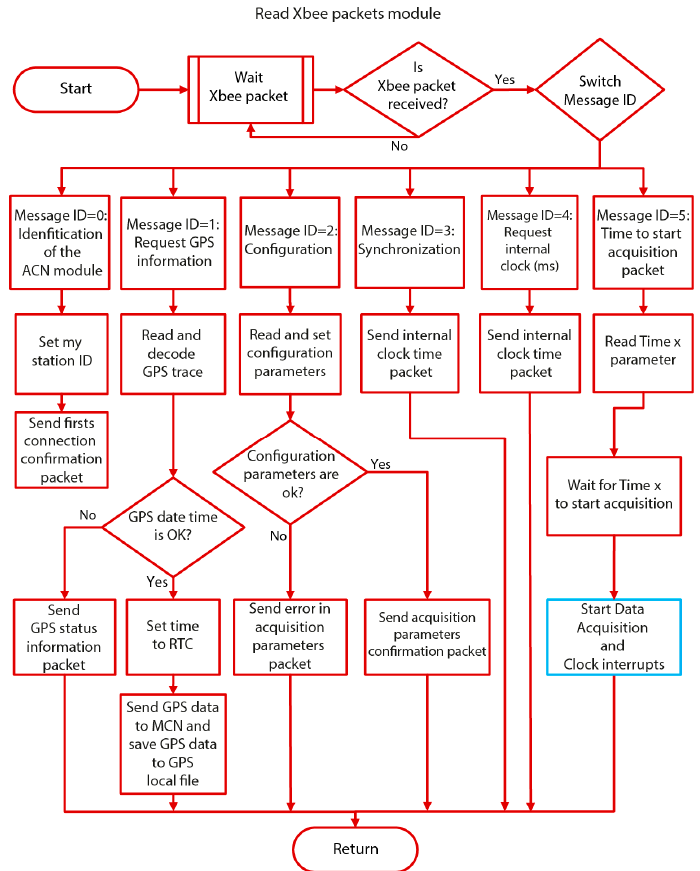
Figure 9. General flowchart of the ACN software.